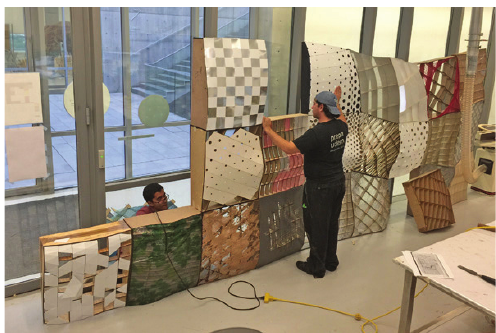
Figure 5. Mounting the cells into the whole installation assembly of the parametric wall